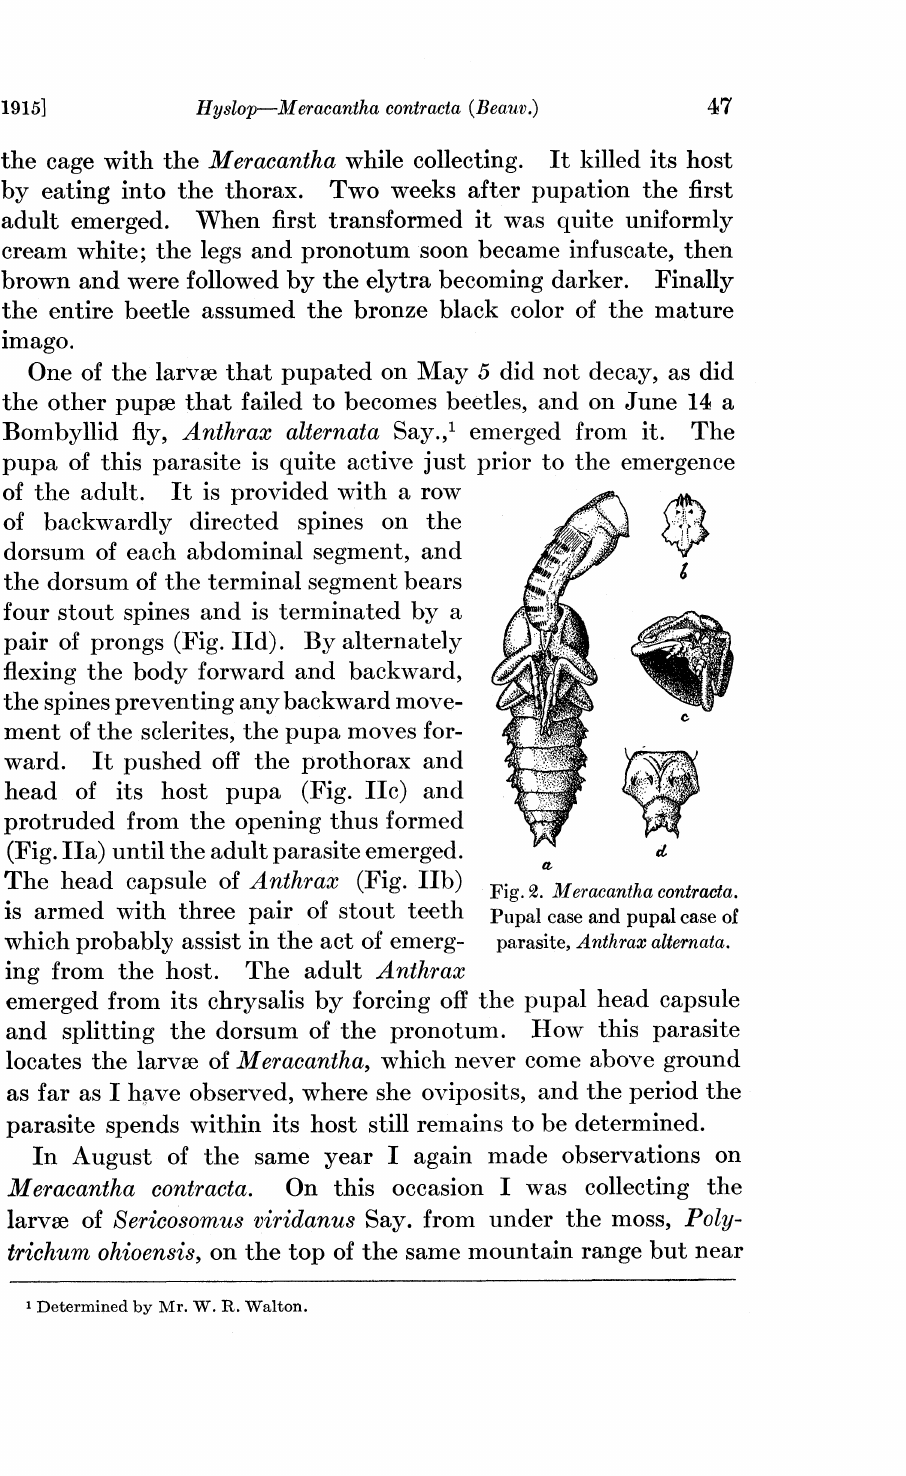
. Meracantha contracta. Fig. Pupal case and pupal case parasite, Anthrax